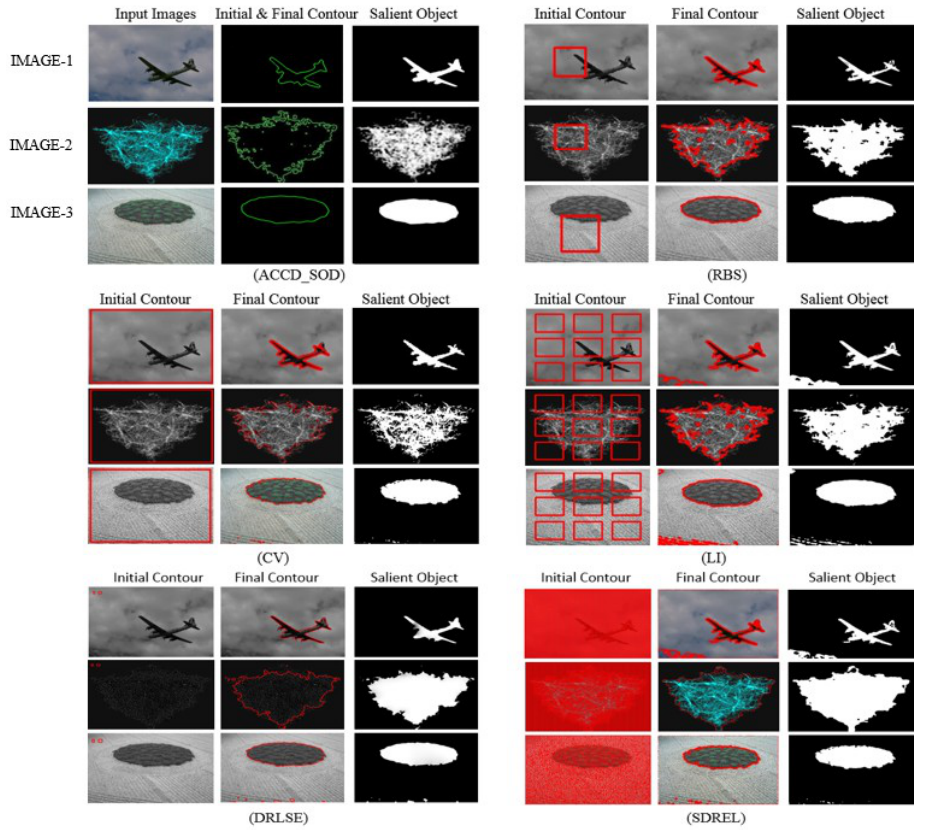
Figure 4. Initial contour, final contour and salient object results of RBS, Chan and Vese (CV), LI, DRSLE, SDREL, and our proposed algorithm ACCD_SOD. Our algorithm directly fitted during the initial stage, while the other state-of-the-art models failed during the initialization stage, which increased the computational cost.